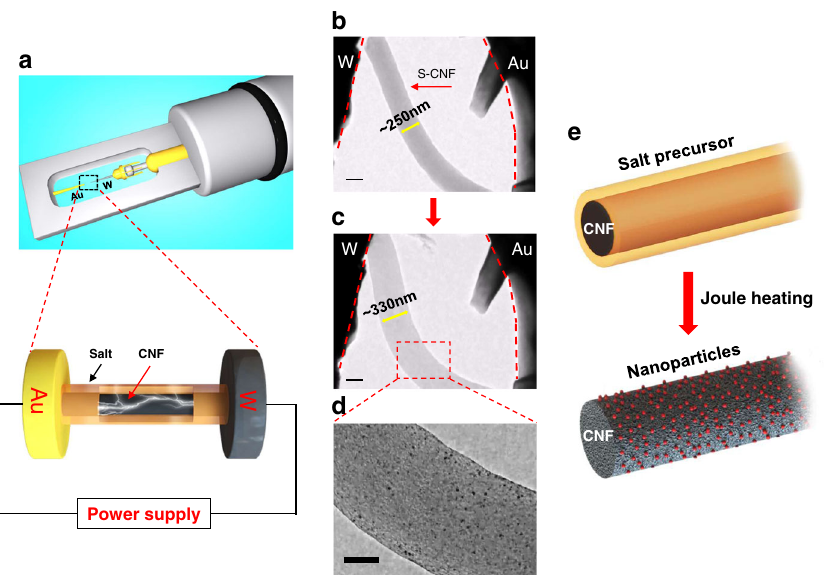
Fig. 1 In situ TEM observation of Pt nanoparticles formation on H 2 PtCl 6 -loaded CNF through electrical Joule heating. a Schematic images of electrical biasing TEM holder and the zoomed-in view of the salt-loaded nano fi bers between Au and W electrodes. b – d TEM images depict the CNF expansion and the formation of Pt nanoparticles on CNF. Scale bars are 200 nm in ( b , c ), 100 nm in ( d ). e The schematic of the S-CNF before and after the Joule